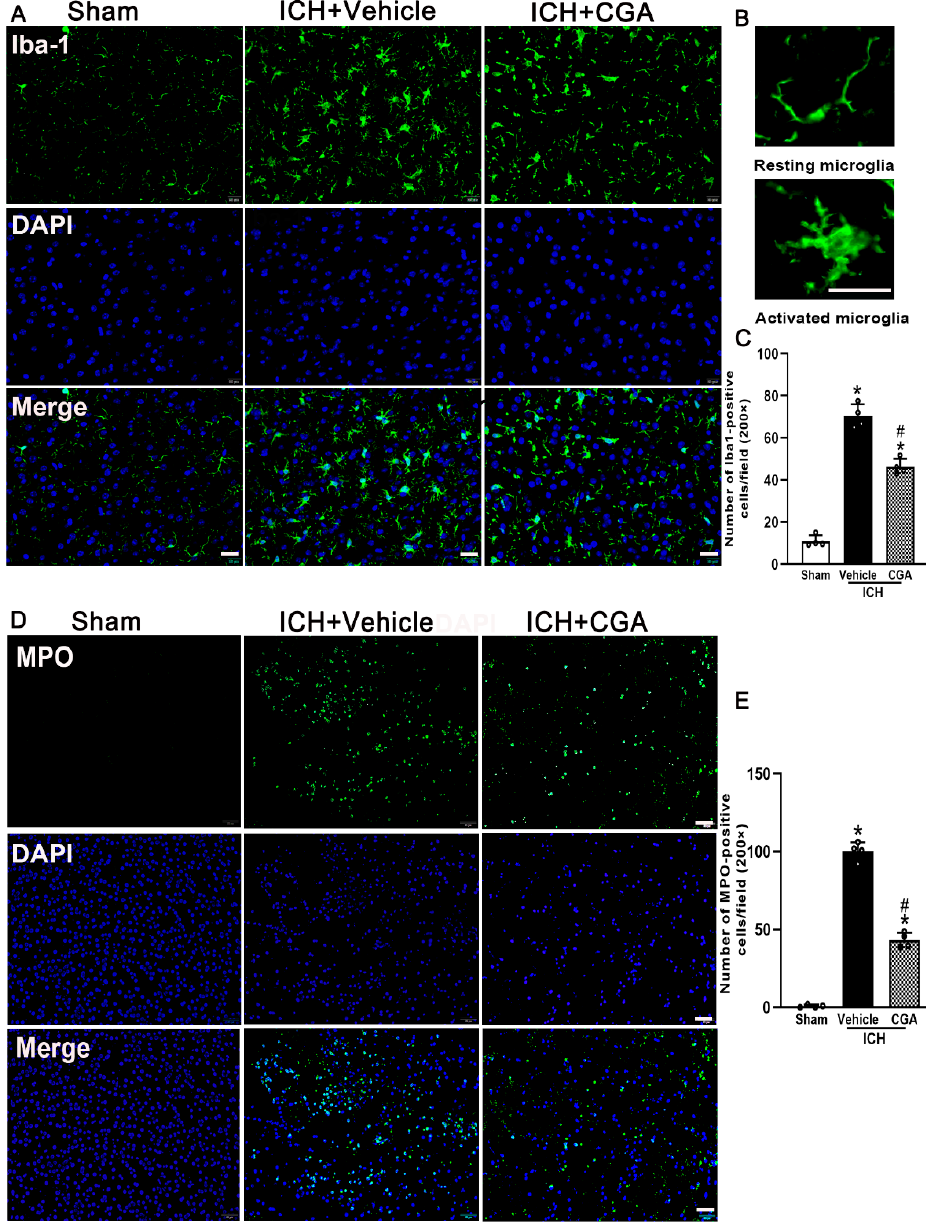
Figure 5. The effects of CGA on microglia/macrophage activation and neutrophil infiltration at 3 days after ICH. ( A ) Representative photographs of immunofluorescent staining for Iba-1-positive microglia. Scale bar = 20 μ m. ( B ) Representative photographs of the morphology of resting (up) and activated (down) microglia. Scale bar = 20 μ m. ( C ) Quantification analysis shows that CGA significantly decreased the number of activated microglia. ( D ) Representative photographs of immunofluorescent staining for MPO-positive neutrophils. Scale bar = 20 μ m. ( E ) Quantification analysis shows that CGA significantly reduced neutrophil infiltration (* p < 0.01 vs. sham; # p < 0.01 vs. ICH + vehicle group). Data are presented as mean ± SD; n = 4 for each group.